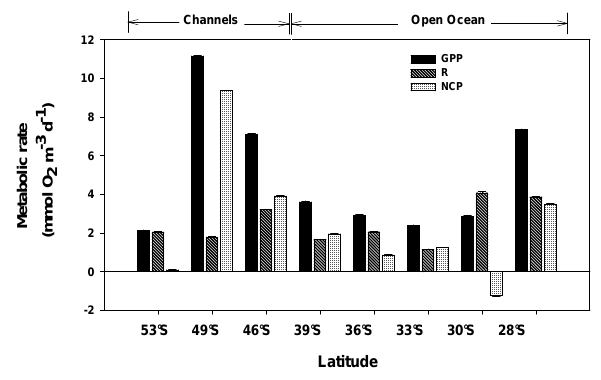
Fig. 5. Average plankton metabolic rates (mean ± SE for GPP, R and NCP) at the surface water (5m) along the Chilean coast.